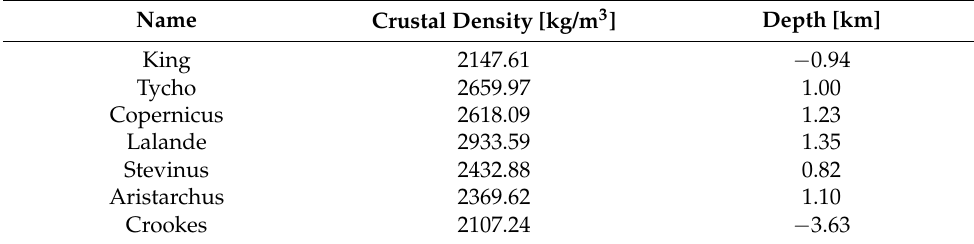
Figure 2. Localized admittance for each target region. Here, ( a ) represents all regions and ( b ) is cropped and expressed separately because the admittance of Crookes is extremely large to estimate the change in admittance in other regions. Crookes and King are located in the highlands (high elevation), and all other areas are located at mare or near mare. The admittances of Crookes and King increased due to the difference in topography (according to location). Marius Hills (yellow) was not a target area but an area for validating our method. The red color in the background was the range used to calculate the localized crustal density. Table 2. Localized crustal density and depth of target areas.